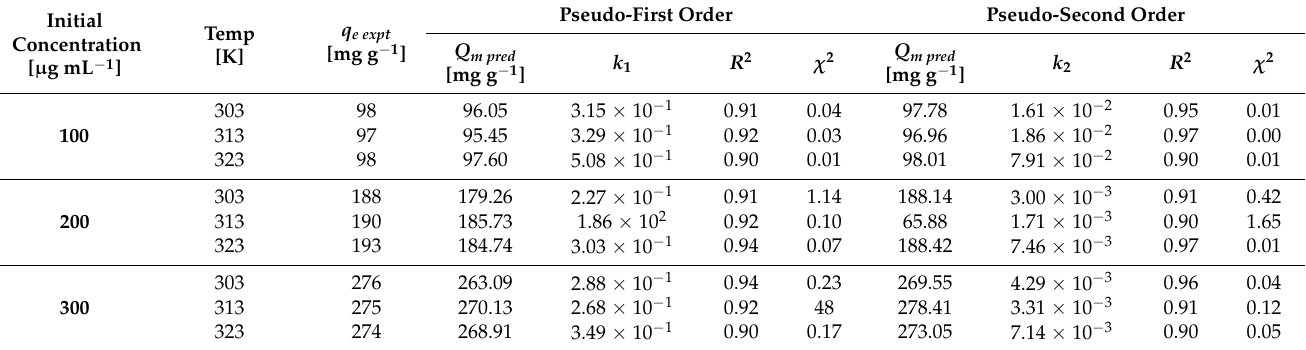
Table 1. Experimentally determined and theoretically predicted parameters for adsorption kinetics